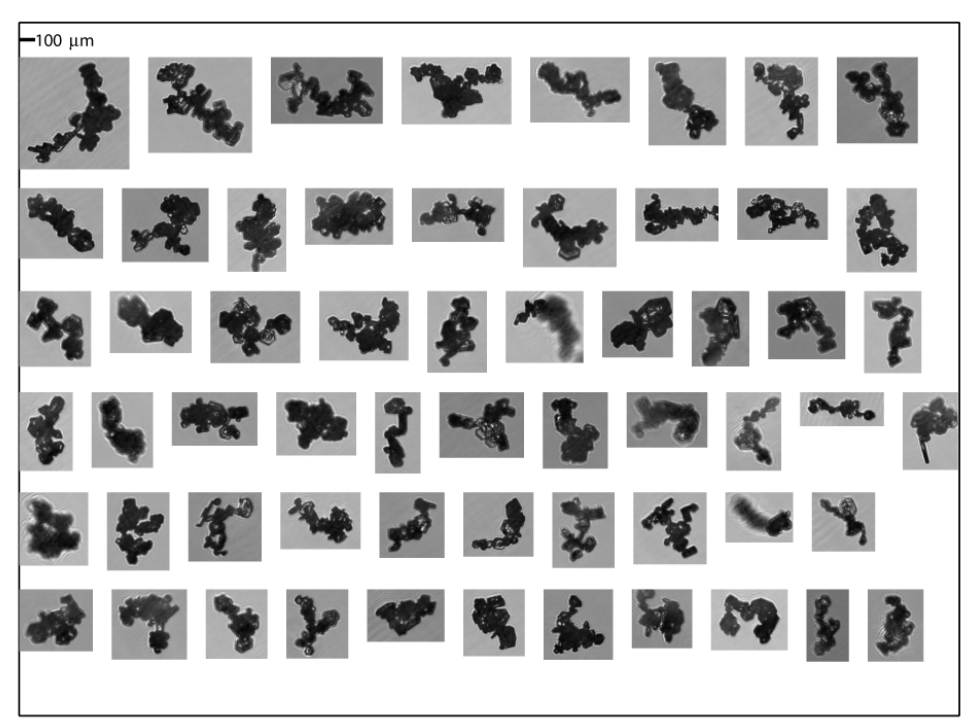
Fig. 10. Close up view of typical complex chain aggregates of hexagonal plates observed within a Hector storm outflow (temperatures T < − 50 ◦ C) during the EMERALD-II experiment (Connolly et al., 2007).